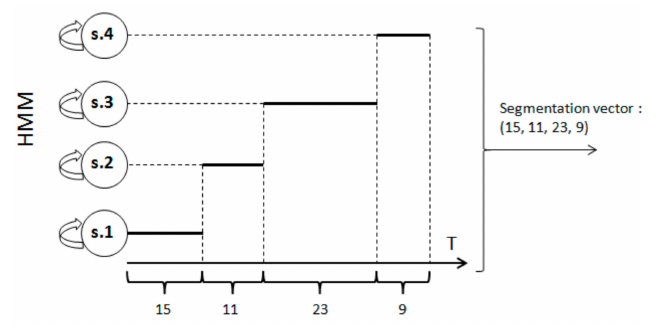
Figure 6. Computation of a signature’s segmentation vector generated by the user’s HMM. Feature vectors describing the signature are on the x -axis and the left-to-right HMM on the y -axis.